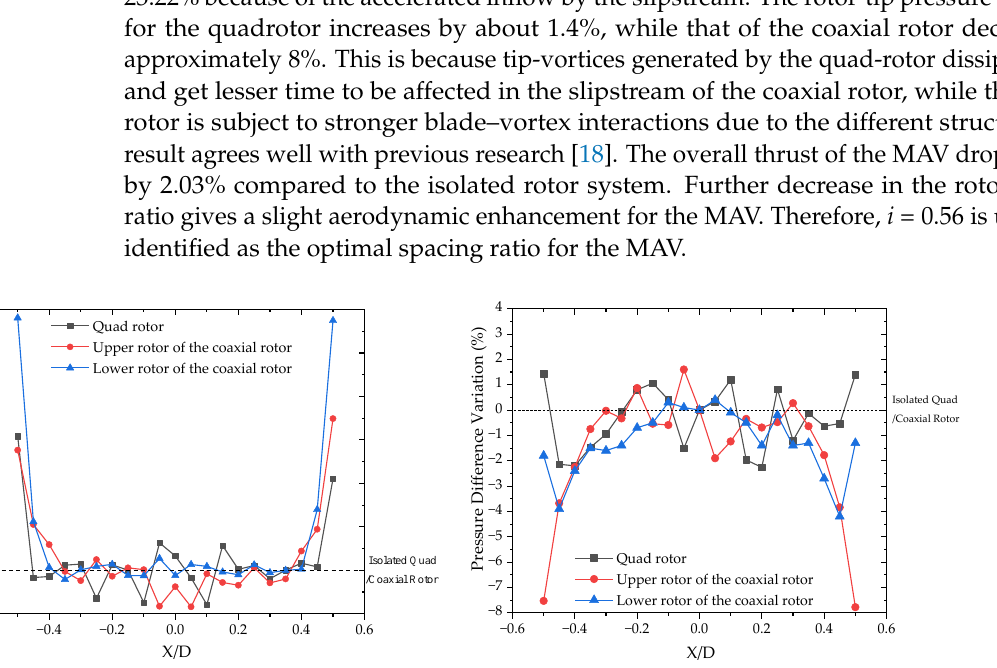
Figure 11. Vectors distribution at Re = 0.89 × 10 5 . ( a ) i = 0.71; ( b ) i = 0.63; ( c ) i = 0.56.